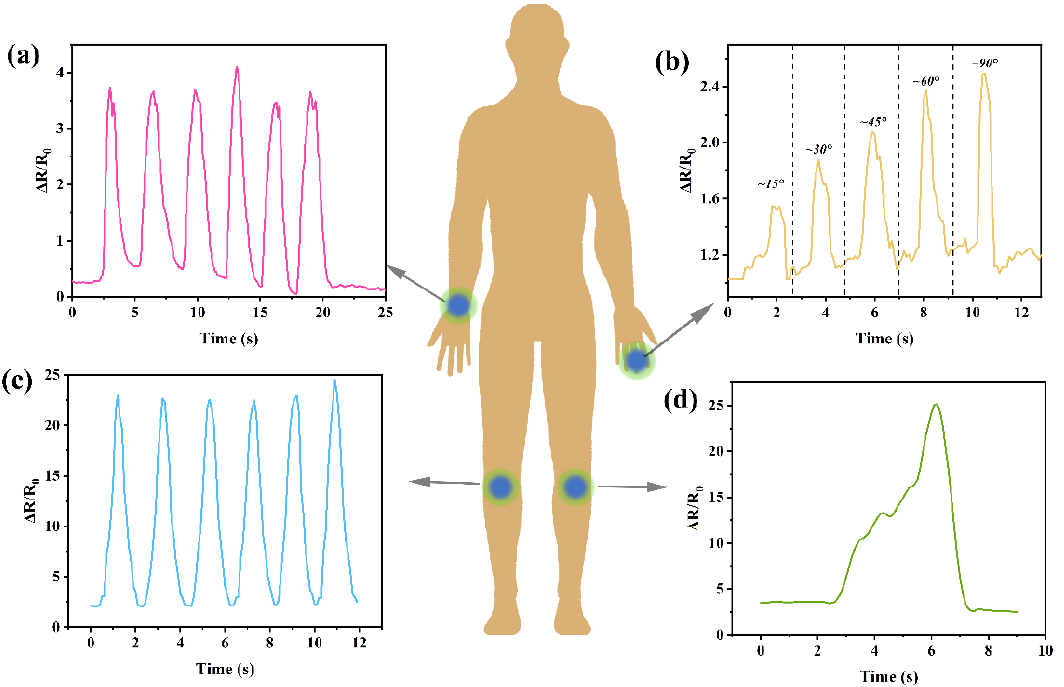
Figure 5. Applications for human motion monitoring: ( a ) bending the wrist, ( b ) bending fingers with different angles, ( c ) walking monitoring, and ( d ) slowly bending the knee.